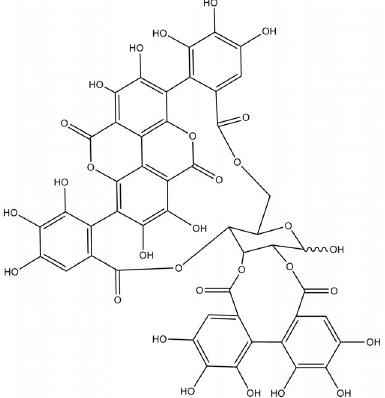
Figure 1. Molecular structure of punicalagin .